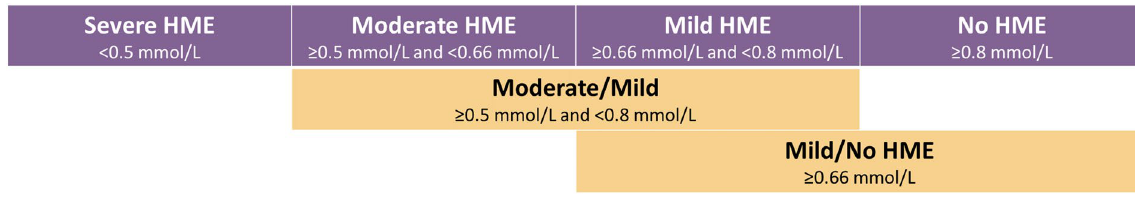
Figure 1. Subgroup categories and relative serum Mg concentration ranges. HME